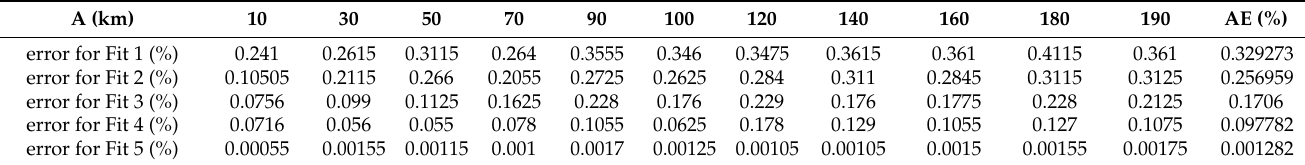
Table 8. LL fault prediction error.